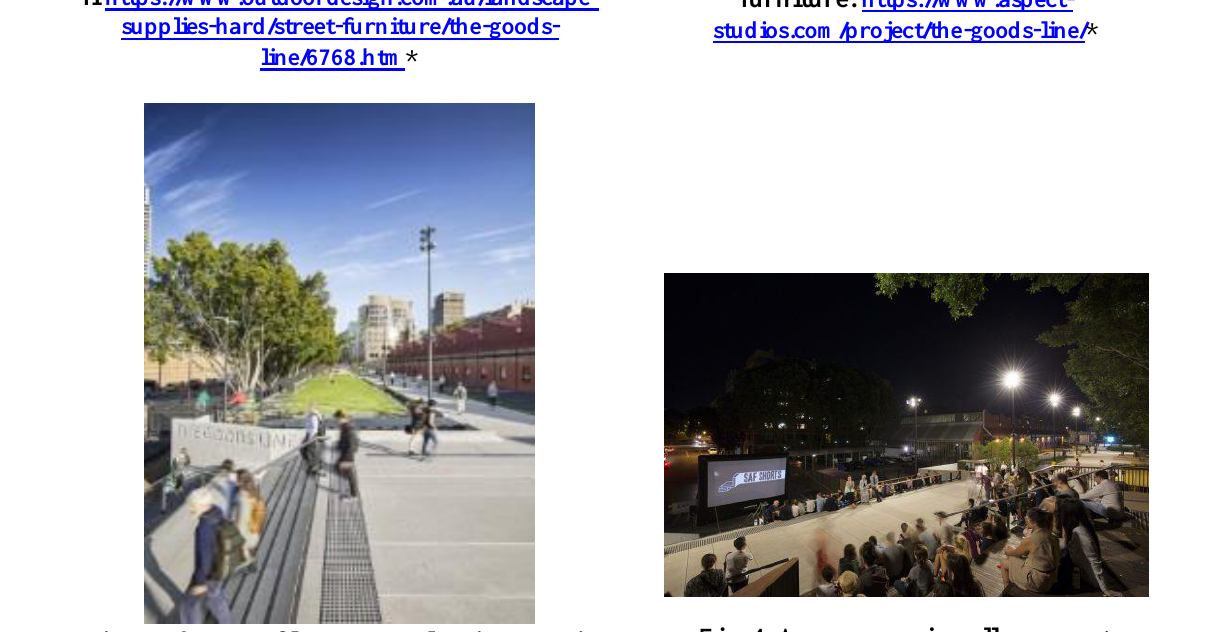
Fig. 4. A space serving all groups. *